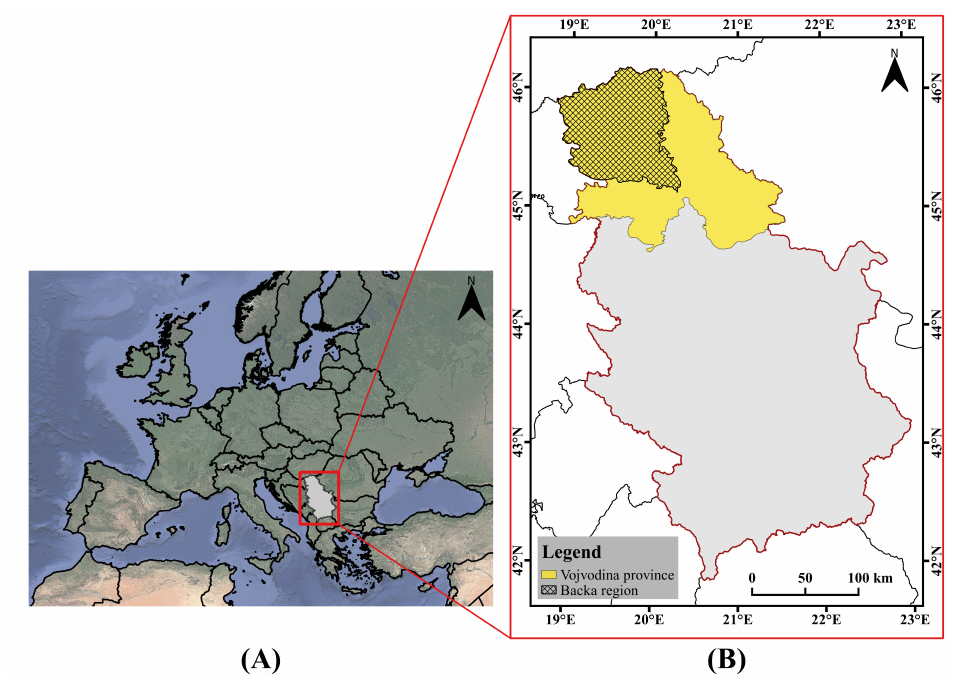
Figure 1. Location of Serbia in Southeastern Europe ( A ) and the study area ( B